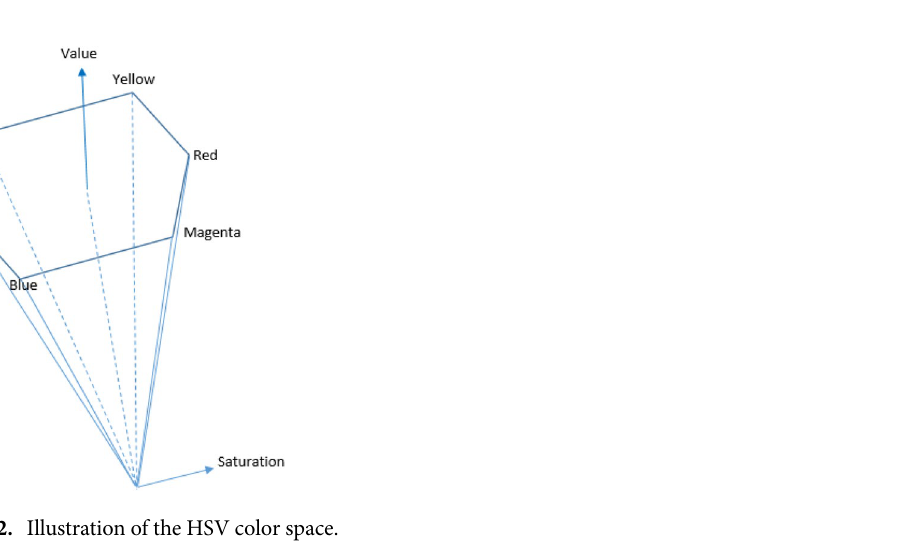
Figure 1. Illustrates the flowchart of the proposed approach for missing color area extraction.